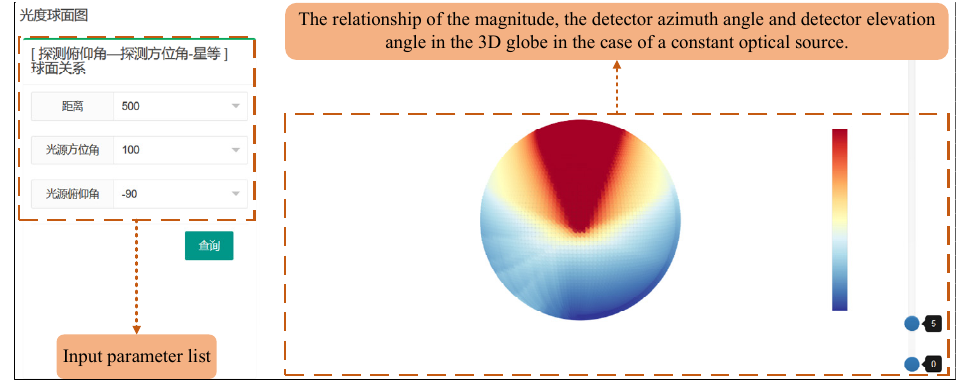
Figure 15. 3D heatmap of the magnitude of the Worldview 1 satellite. In this figure, the values of optical source pitch, optical source azimuth, and equivalent distance are − 90°, 100°, and 500 km, respectively.